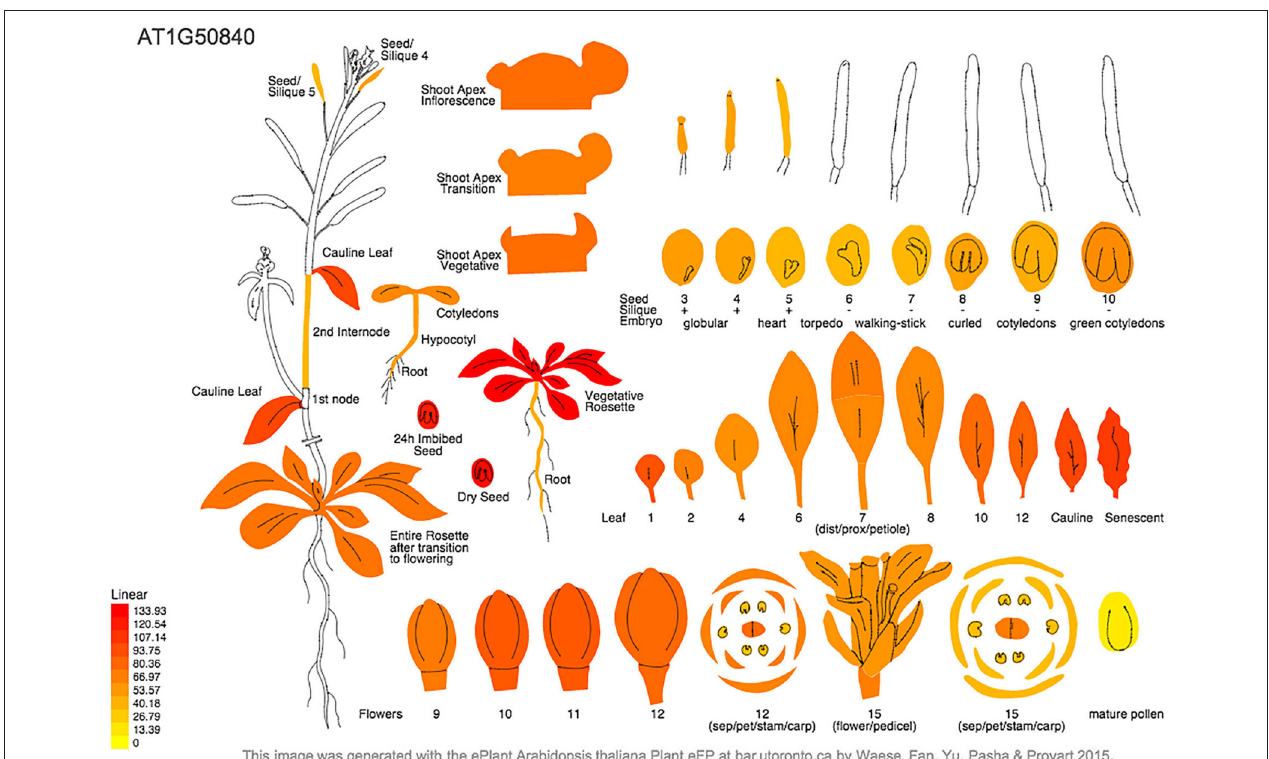
FIGURE 4 | Arabidopsis eFP browser report showing predicted PolIA gene expression in different plant tissues. Expression of Pol1A is highest in rosette leaves, particularly at a young age, however, expression remains relatively high even in senescing leaves. Expression of Pol1A is lowest in seed embryos and pollen.